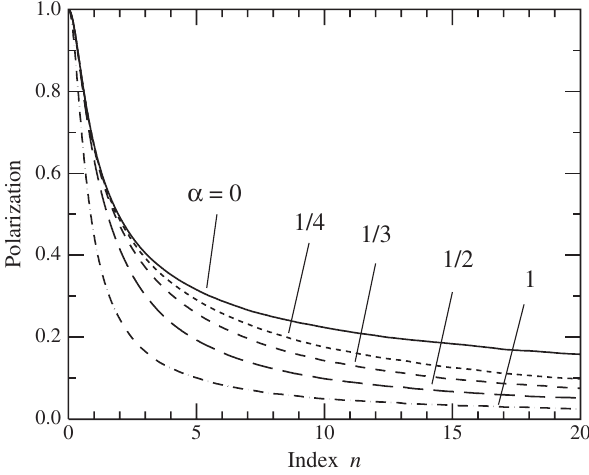
FIG. 12. Five sample templates for the time dependence of the horizontal polarization in arbitrary index units. The values for α are marked for each template. Values of α near zero represent a wide but vertically short beam. A value of α ¼ 1 represents a round beam. These curves include a factor of coordinate as discussed in the text.